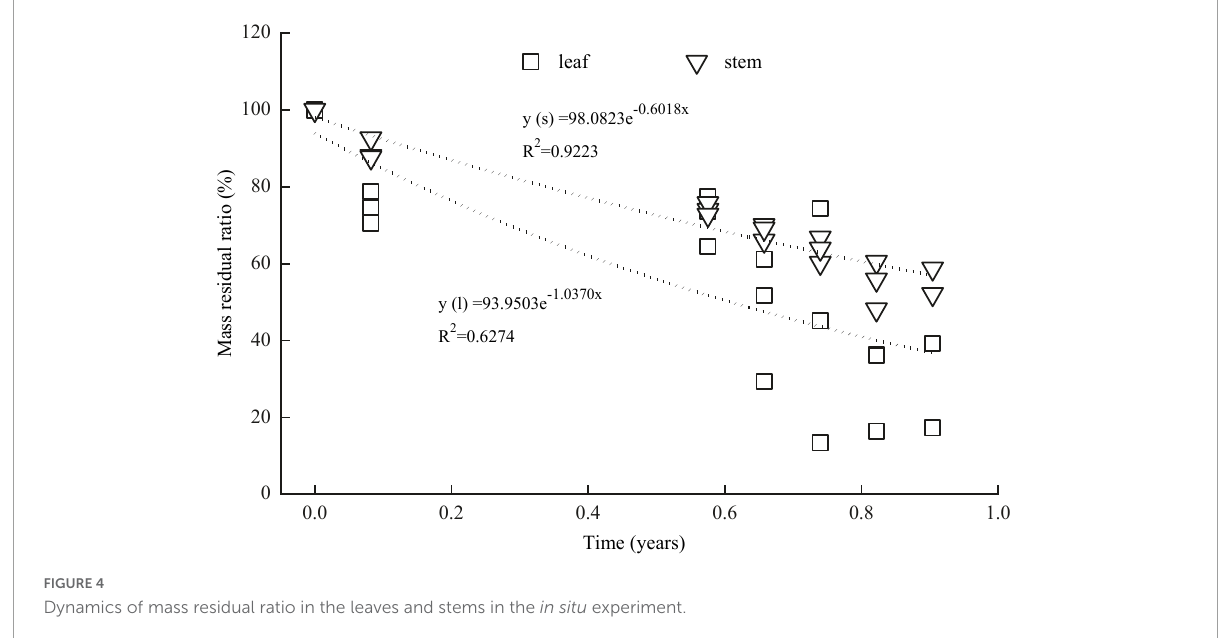
FIGURE4 Dynamics of mass residual ratio in the leaves and stems in the in situ experiment.